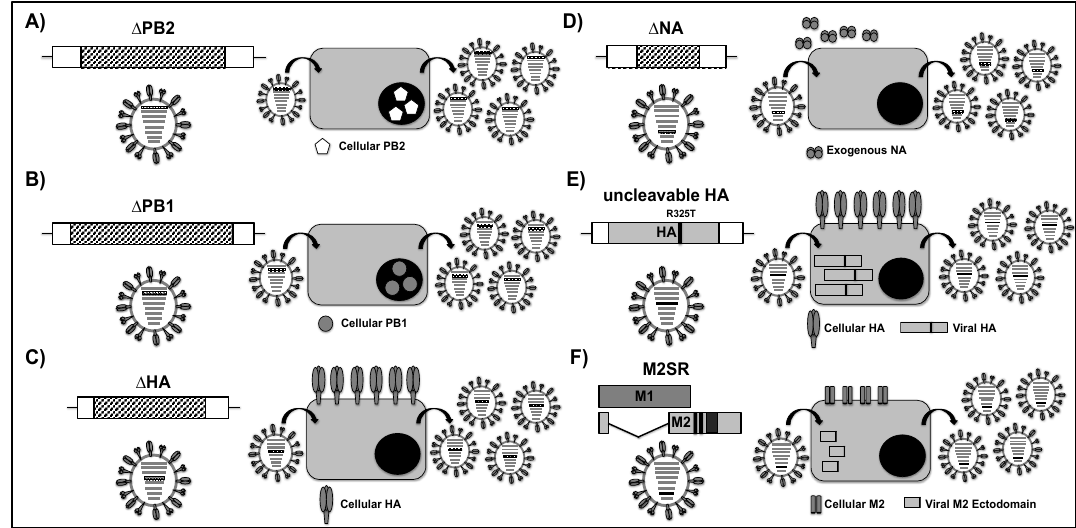
Figure 9. Single-cycle infectious IAV (sciIAV) as LAIV: Schematic representation of sciIAV based on deletions in the PB2 ( A ), PB1 ( B ), HA ( C ), or NA ( D ) viral proteins. SciIAV based on a modified uncleavable HA ( E ) or a non-functional M2, M2SR ( F ) are also indicated. The packaging signals located at the 3’and 5’ ends of each vRNA are indicated with white boxes ( A – F ). Lines at the end of each vRNA indicate the 3’and 5’ NCRs ( A – F ). Striped boxes represent an internal deletion of the PB2 ( A ), PB1 ( B ), HA ( C ), or NA ( D ) ORF. A black line represents an amino acid substitution (R325T) in the cleavage site of HA that results in an uncleavable HA protein ( E ). A black box represents the deletion of the M2 transmembrane domain (amino acids 25 to 53) that together with the insertion of two stop codons (black lines) downstream of M1 ORF abolish M2 expression ( E ). In the case of ∆ PB2 ( A ), ∆ PB1 ( B ), ∆ HA ( C ), uncleavable HA ( E ), and M2SR ( F ) sciIAVs, efficient viral replication is accomplished by complementation, in trans , of the deficient ( A – C ) or mutated ( E – F ) viral proteins by constitutively expressing PB2 ( A ), PB1 ( B ), HA ( C , E ), or M2 ( F ) using stable cell lines. In the case of the ∆ NA sciIAV ( D ), exogenous NA is provided in the tissue culture supernatant for the efficient release of infectious viral particles.